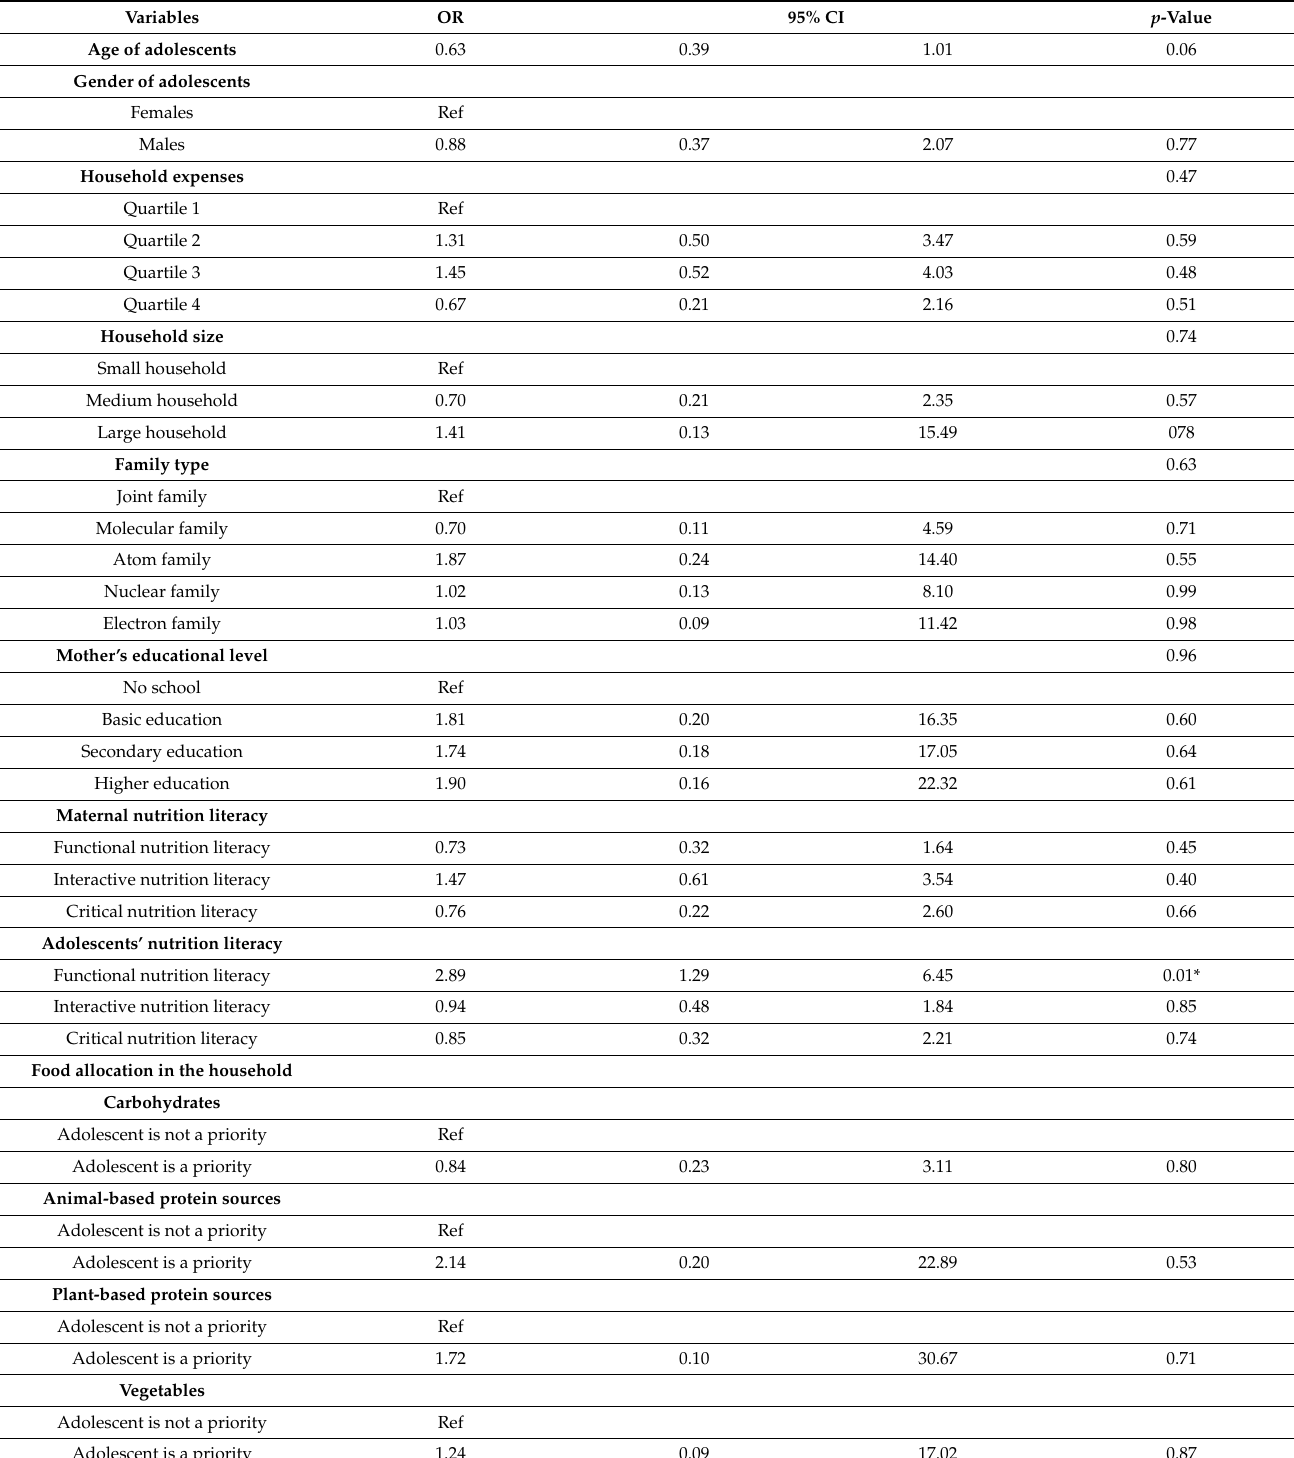
Table 6. Logistic regression model of the relationship between diet-related behaviors and other characteristics with the diet quality